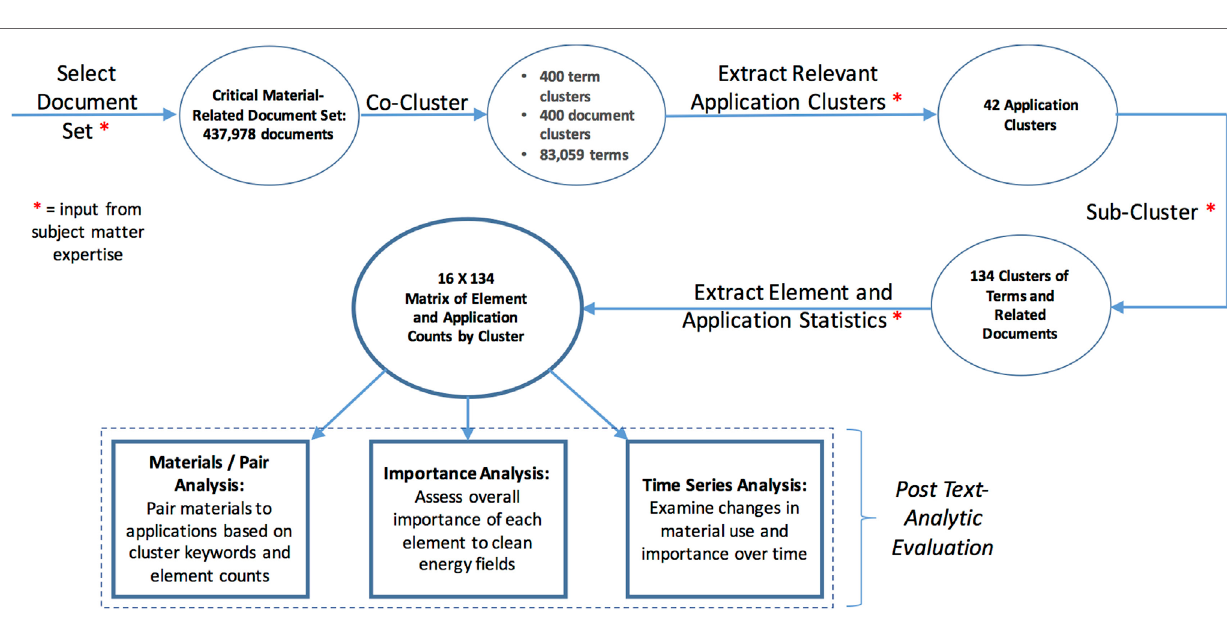
FigUre 2 | Diagram of the text analytics workflow that this project developed. This work flow was utilized to identify material–application